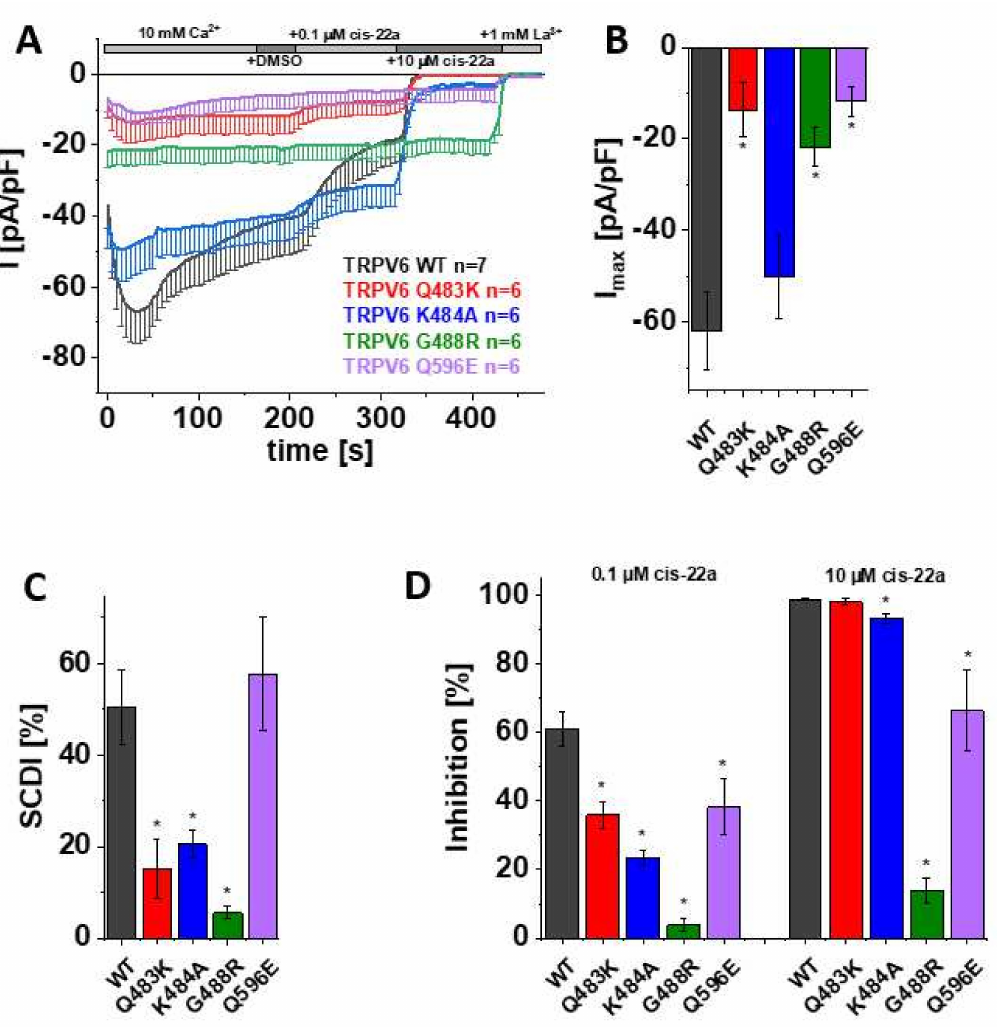
Figure 2. Mutations in LBS-2 lead to reduced maximum currents, SCDI and inhibition by cis- 22a. ( A ) Averaged time course of whole-cell currents (mean ± SEM) recorded from HEK 293 cells expressing TRPV6 WT (black), TRPV6 Q483K (red), TRPV6 K484A (blue), TRPV6 G488R (green) and TRPV6 Q596E (purple). Throughout the experiment, application of 10 mM Ca 2+ was followed by consecutive addition of DMSO, 0.1 µ M cis-22a, 10 µ M cis-22a, and 1 mM La 3+ , as indicated by the grey bars. ( B ) Block diagram of maximum currents according to measurements in ( A ). ( C ) Block diagram of the extent of SCDI in % according to measurements in ( A ). ( D ) Block diagram of the extent of inhibition in % by 0.1 µ M (left) and 10 µ M (right) cis-22a according to measurements in ( A ). The asterisk (*) indicates the statistical significance ( p < 0.05) in comparison to TRPV6 WT. 3.4. Preincubation with Cholesterol Oxidase (CO) Has No Effect on Maximum Currents and SCDI of TRPV6